Question: Give a one-sentence summary of this figure.
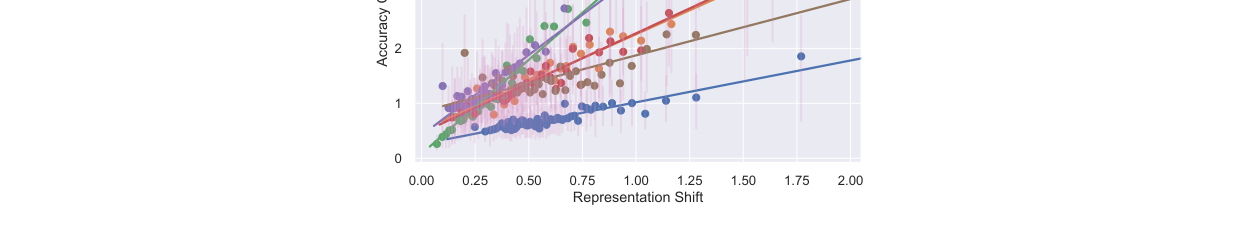
Answer: Binned scatter plot showing for the MiniImageNet disjoint tasks setting the change in accuracy against the mean change in representation after learning on a batch for the test data of the first task.